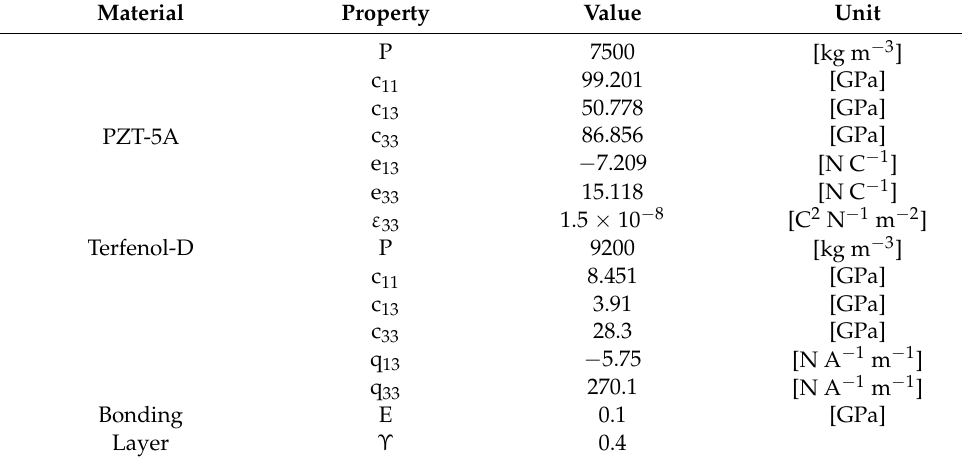
Table 2. Material properties of the piezoelectric, piezomagnetic, and the elastic bonding layer [30].